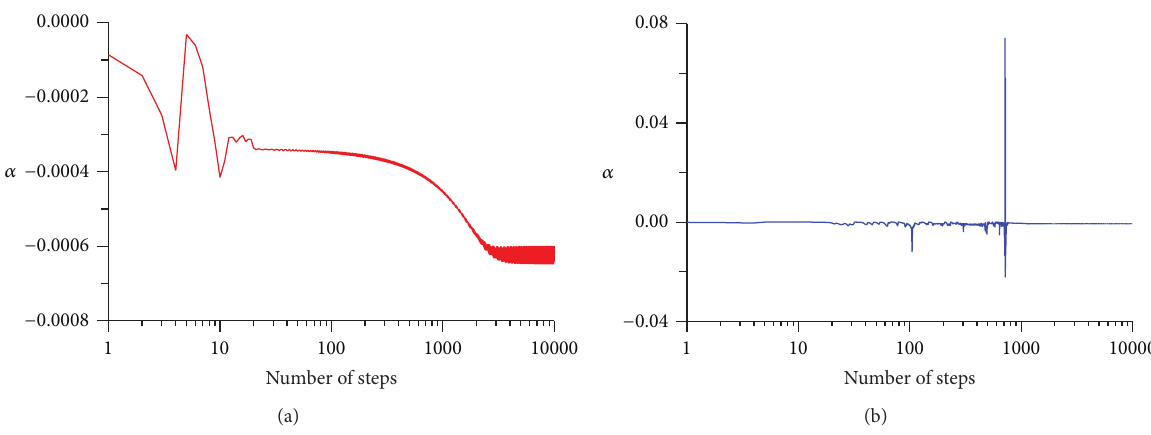
Figure 3: In the solution of the generalized Rosenbrock problem by the OA and GOA, showing the variation of optimal values of 𝛼 for (a) OA and (b)